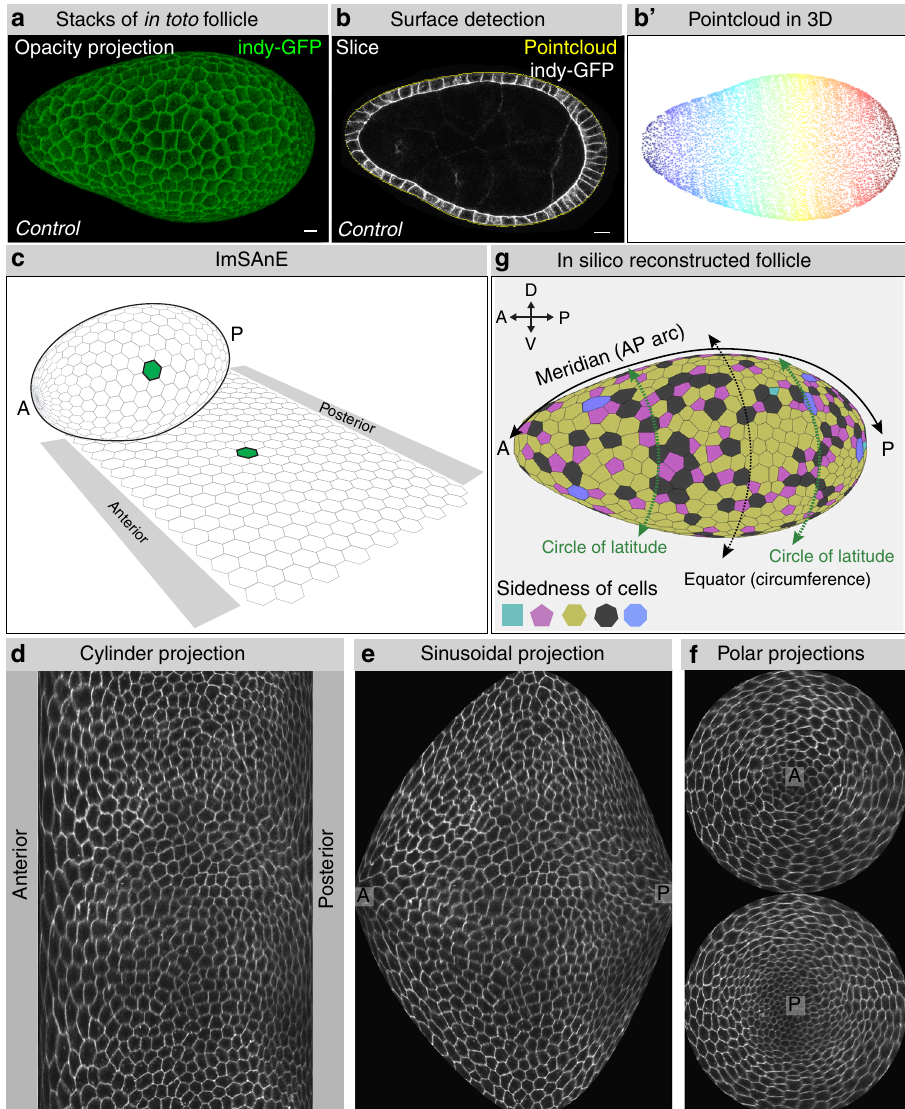
Fig. 1 Work fl ow for in toto follicle morphometrics extraction. a Full 3D stacks of non-compressed Indy-GFP (green) expressing follicles are obtained with confocal microscopy ( b ), after which a 3D pointcloud ( b ′ ) is extracted from the detected surface ( b ). c – f ImSAnE then converts the pointcloud into various 2D projections of segmented cells. g Projections and segmentation veracity are con fi rmed by 3D reconstruction of the follicle (see also Supplementary Movie 1). This work fl ow enables analyses of poles as well as axes along the follicle epithelium, as de fi ned in ( g ), meridians connecting anterior (A) and posterior (P) poles, and circles of latitudes including the equator (circumference). Scale bars, 10 μ